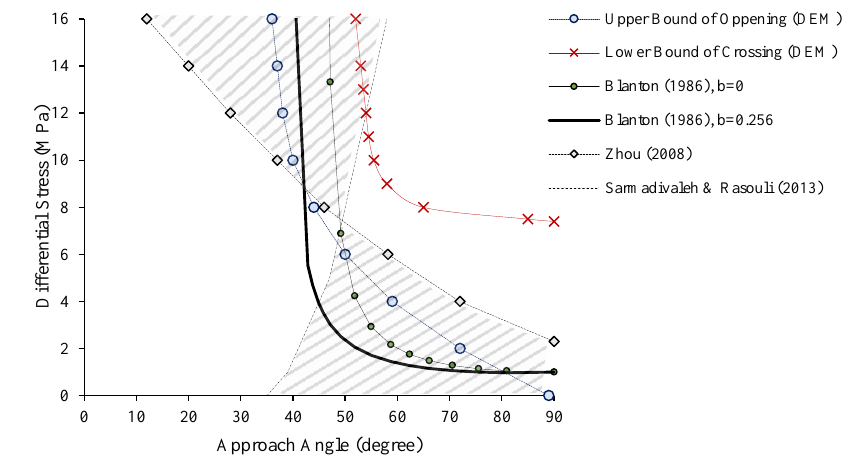
Figure 8. Comparison crossing bound in different methods.